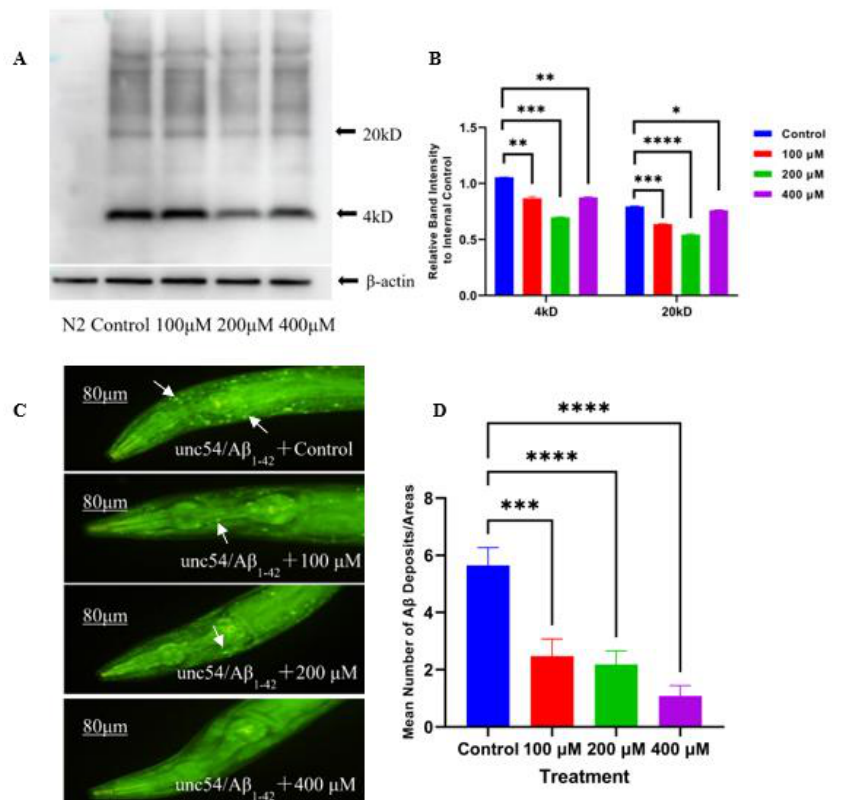
Figure 2. Caesalmin C reduced A β monomers, oligomers and deposits in worms. ( A ) WB assay of A β expression level in transgenic CL4176 worms of each treated group. Wild-type (N2) worms were used as a transgenic control and did not express A β 1–42. β -actin was used as an internal reference. ( B ) The quantitative analysis of A β monomers and A β oligomers in each treated group. ( C ) A β deposits in the pharynx of transgenic CL2006 worms in each treatment group after ThS staining. ( D ) The quantitative analysis of A β deposits in each treated group. In all of the above, worms were treated with 100, 200, and 400 µ M of caesalmin C, respectively, 0.1% ( v / v ) DMSO was used as control. Data are expressed as mean ± SD. The asterisk indicates significant difference compared to the respective control (* p < 0.05, ** p < 0.01, *** p < 0.001, **** p < 0.0001).